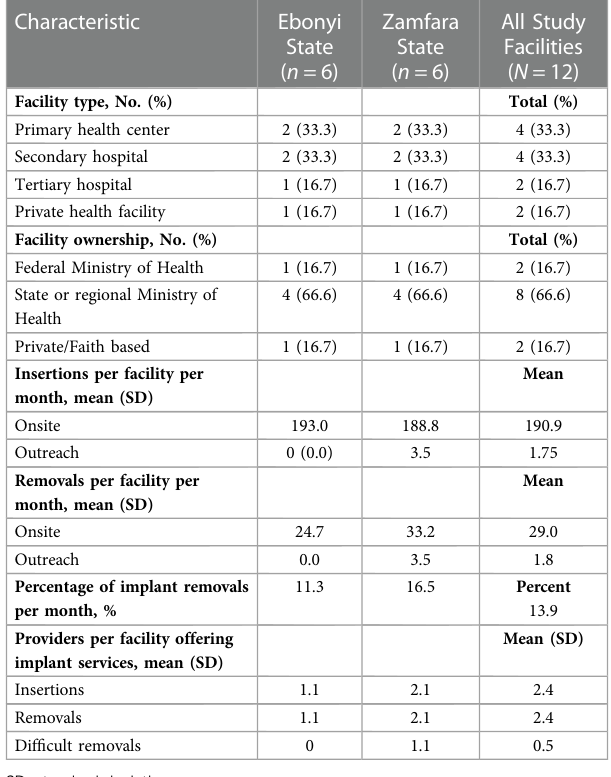
TABLE 1 Health facility characteristics related to implant insertions and removals in Ebonyi and Zamfara States, Nigeria.